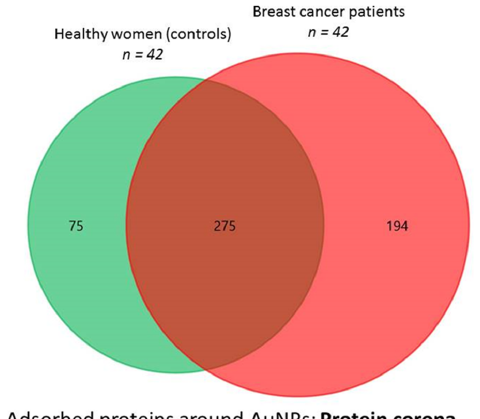
Figure 1. Venn diagram showing the number of proteins identified in the AuNP–protein corona formed after the interaction of AuNPs (10.02 ± 0.91 nm) with serum samples belonging to 42 healthy women (controls) and 42 breast cancer patients.